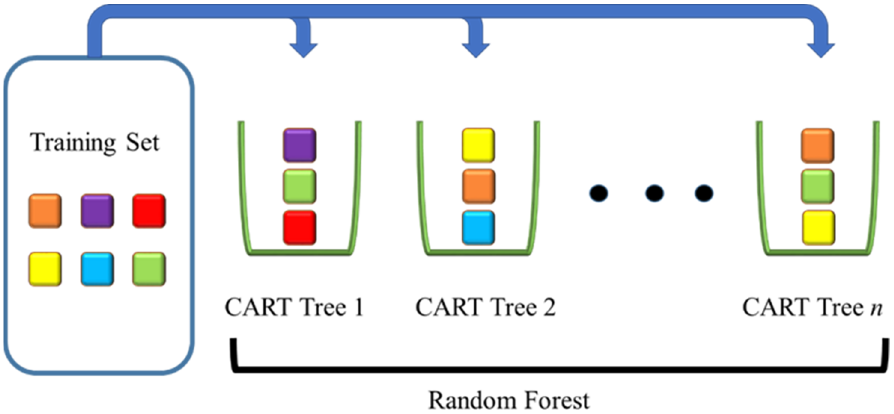
Figure 11. Random forest.